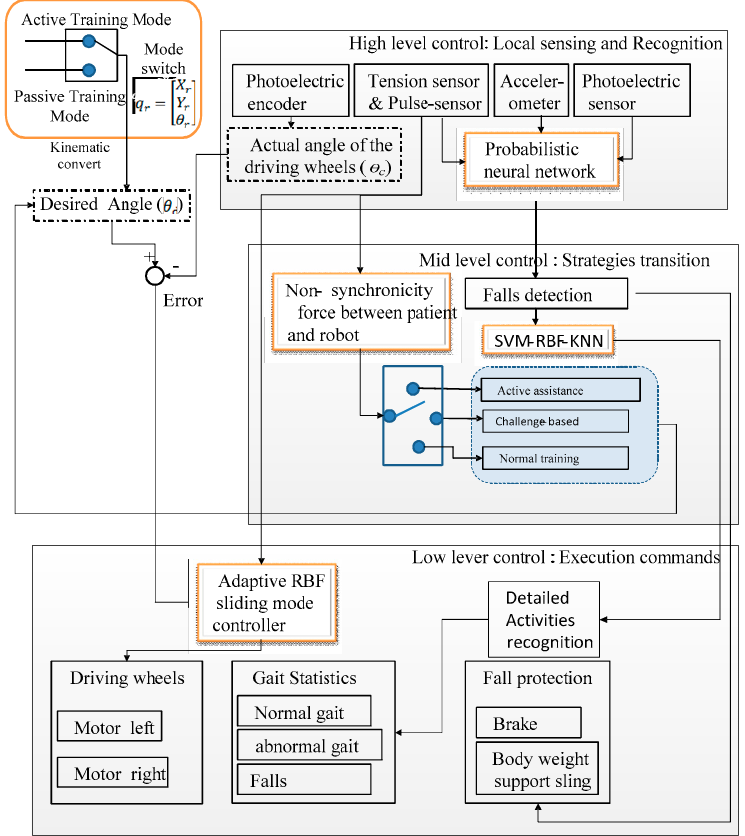
Figure 2. The control system of MCLLRTR.